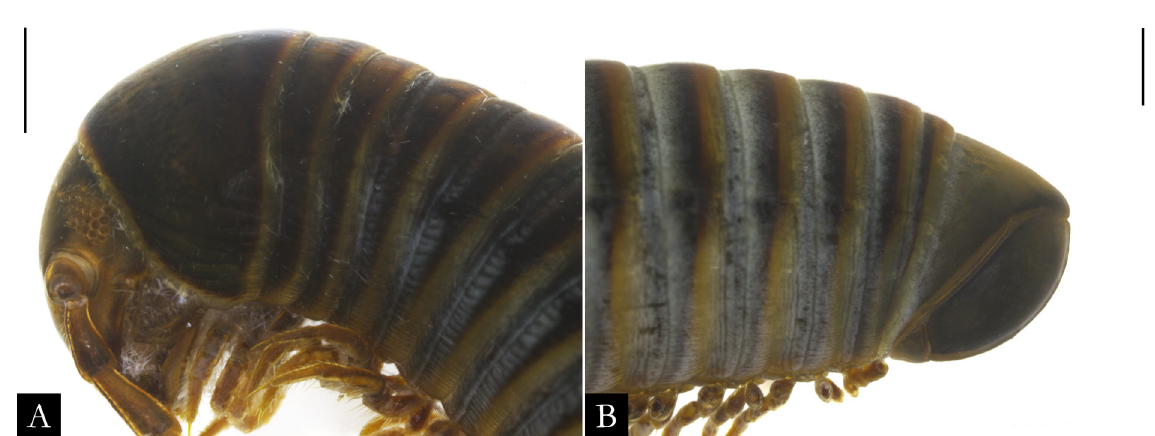
Fig. 136. Pseudonannolene typica Silvestri, 1895, holotype, ♂ (MCSN), in lateral view. A . Anterior region. B . Posterior region. Scale bars = 1